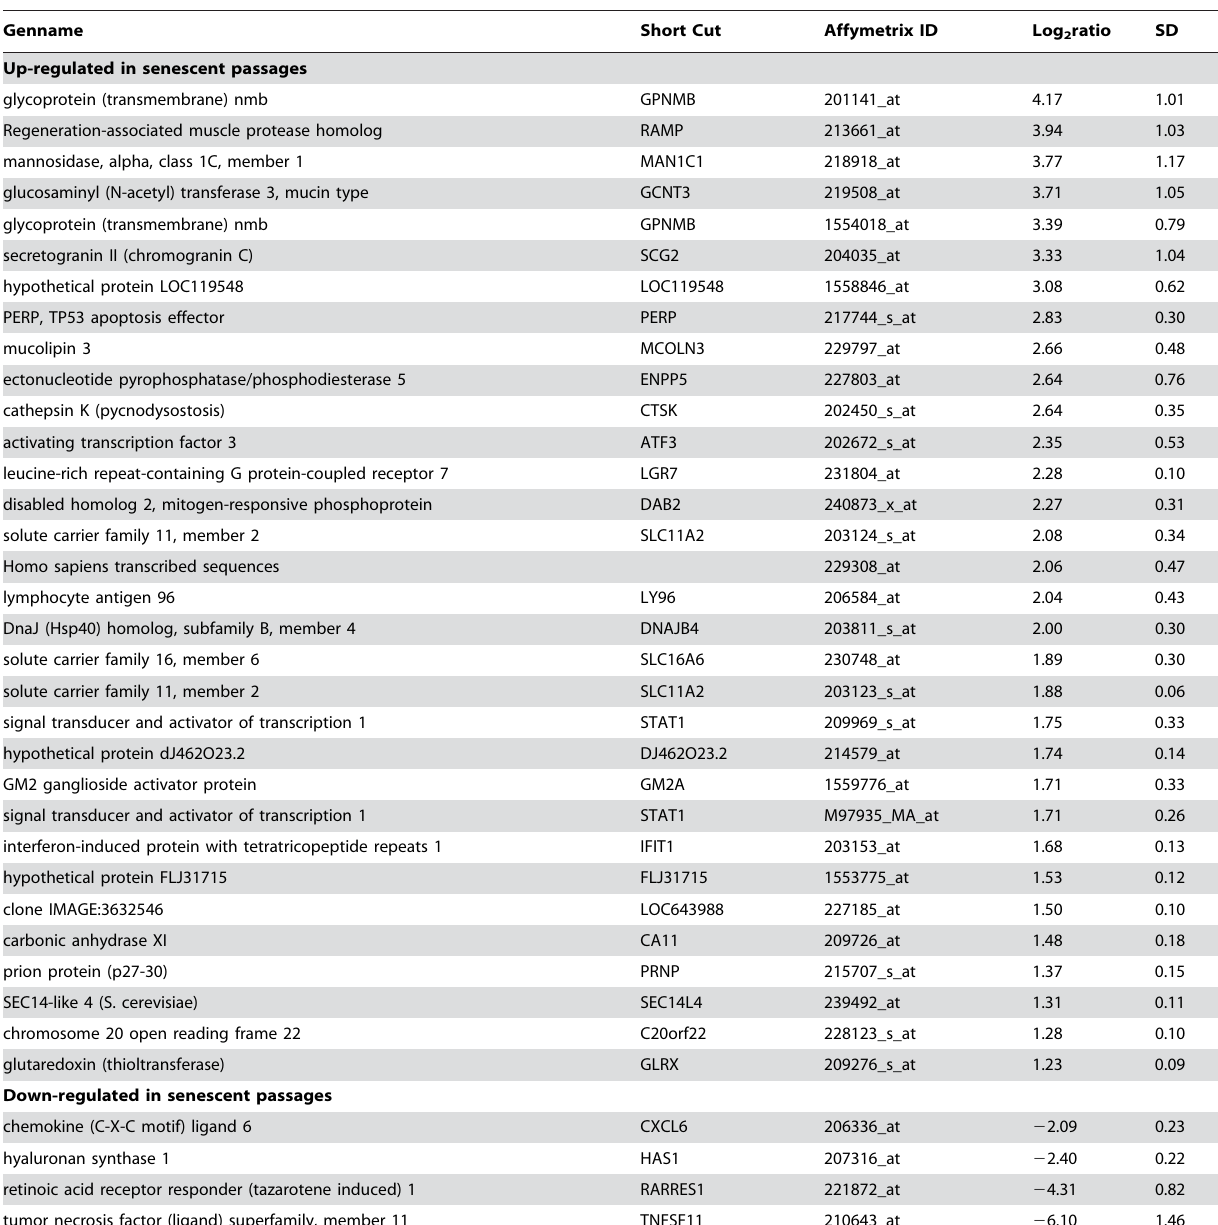
Table 1. Differentially expressed mRNA upon in vitro